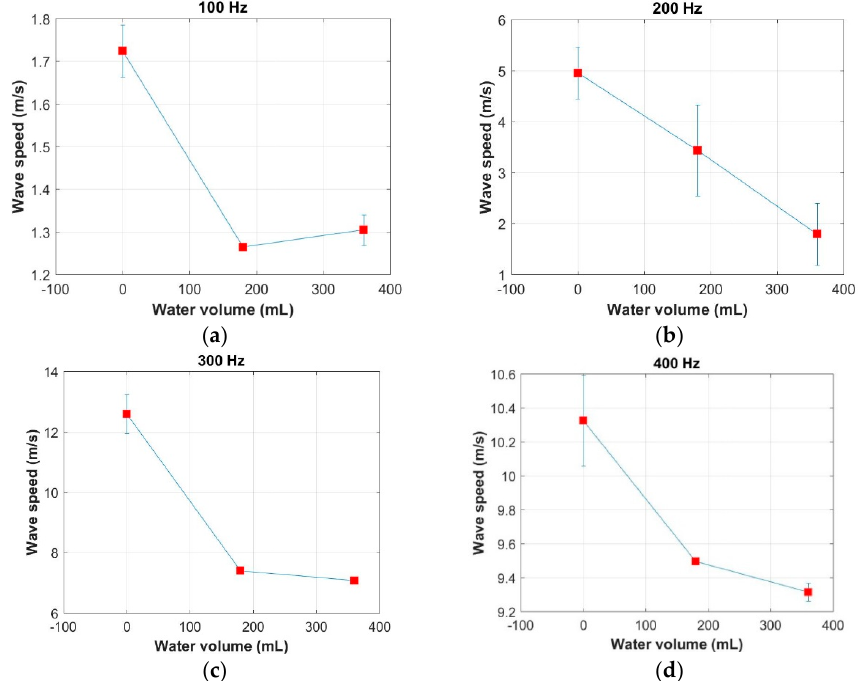
Figure 5. Measurements of surface wave speeds with water volume on another sample of an ex vivo swine lung. ( a ) 100 Hz, ( b ) 200 Hz, ( c ) 300 Hz, and ( d ) 400 Hz. swine lung. ( a ) 100 Hz, ( b ) 200 Hz, ( c ) 300 Hz, and ( d ) 400